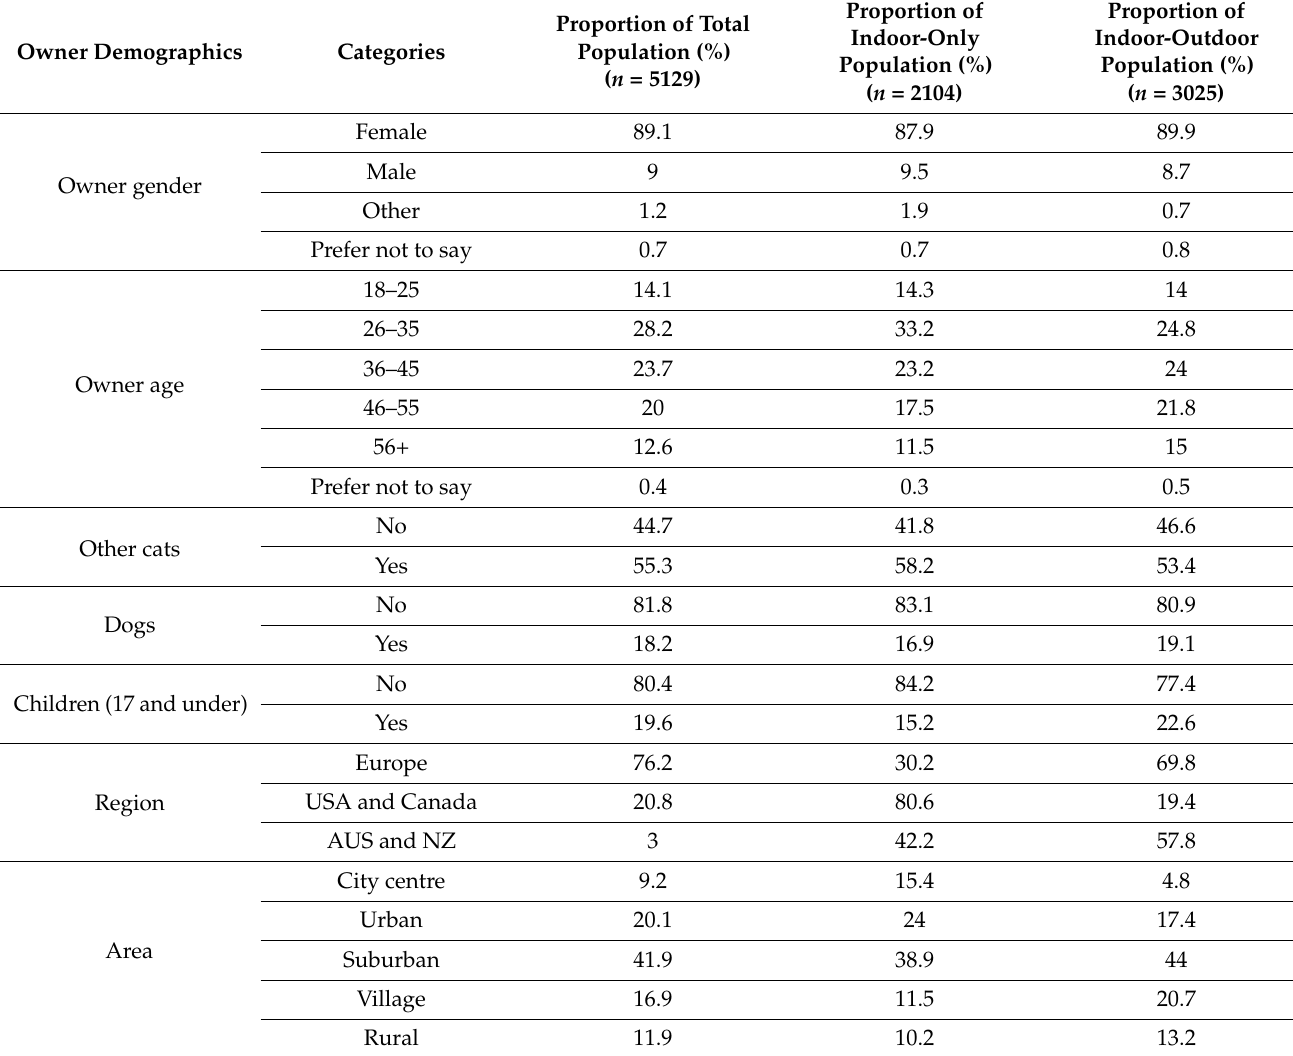
Table 1. Owner demographics and their living environments of the 5129 respondents. Percentages for the entire group of respondents are shown, as are the breakdowns between those who indicated their cat had an indoor-only ( n = 2104) or indoor-outdoor lifestyle ( n =